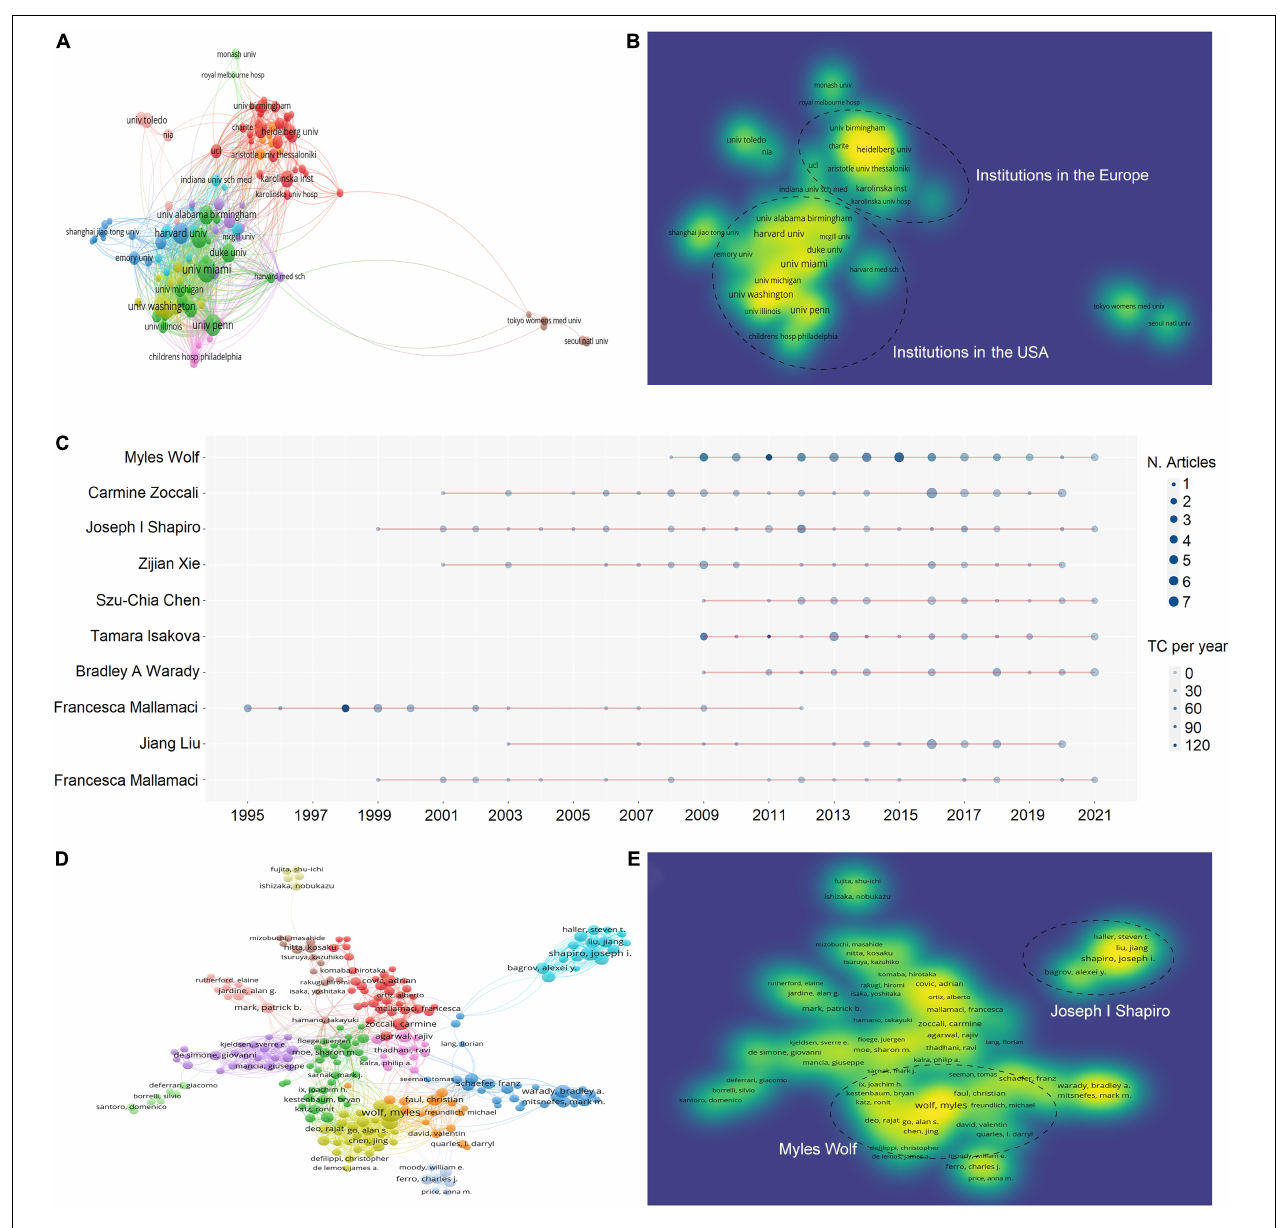
FIGURE 3 | Active institutes and authors analysis. (A) Clustering of collaboration among institutes. (B) Density visualization of institutes based on the mean frequency of appearance and two groups with higher collaboration can be observed. (C) Timeline distribution of publications from the top 10 active authors. (D) Clustering of collaboration among authors. (E) Density visualization of authors based on the mean frequency of appearance and three groups with higher collaboration can be observed.